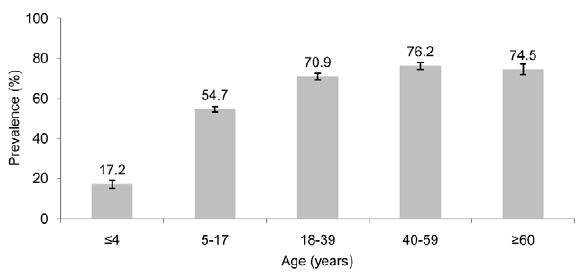
Figure 1. Prevalence of O. viverrini infection in Champasack province, southern Lao PDR, stratified by age group. Data were obtained from cross-sectional surveys carried out in 51 villages of Champasack province between January and May 2007.